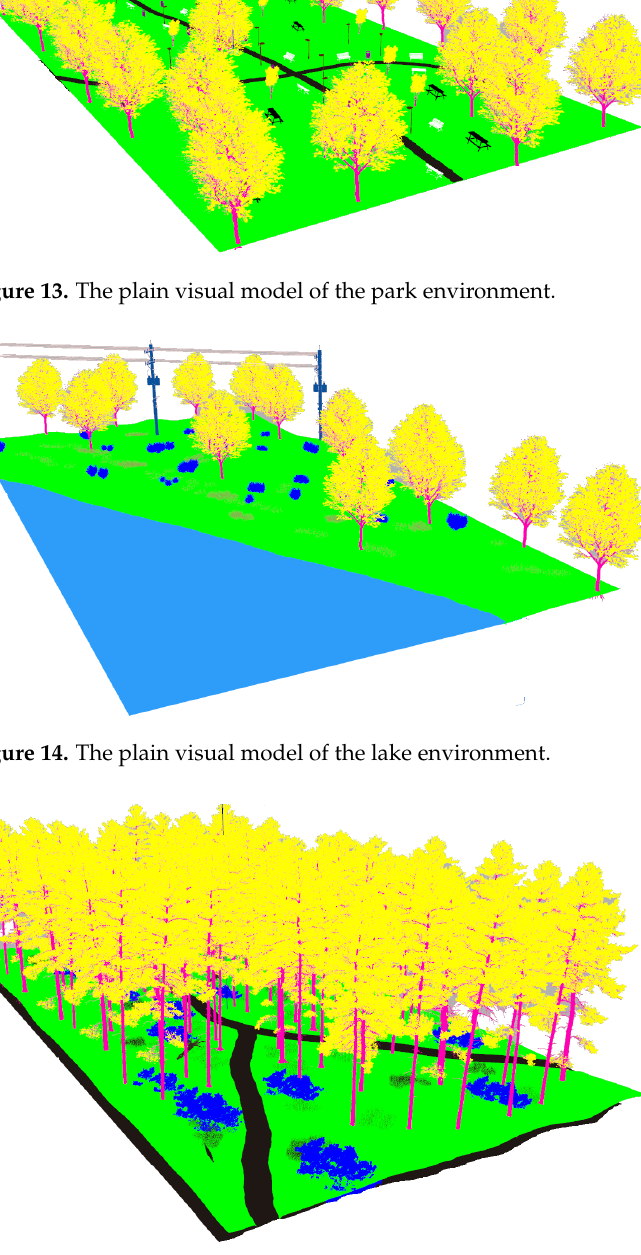
Figure 15. The plain visual model of the forest